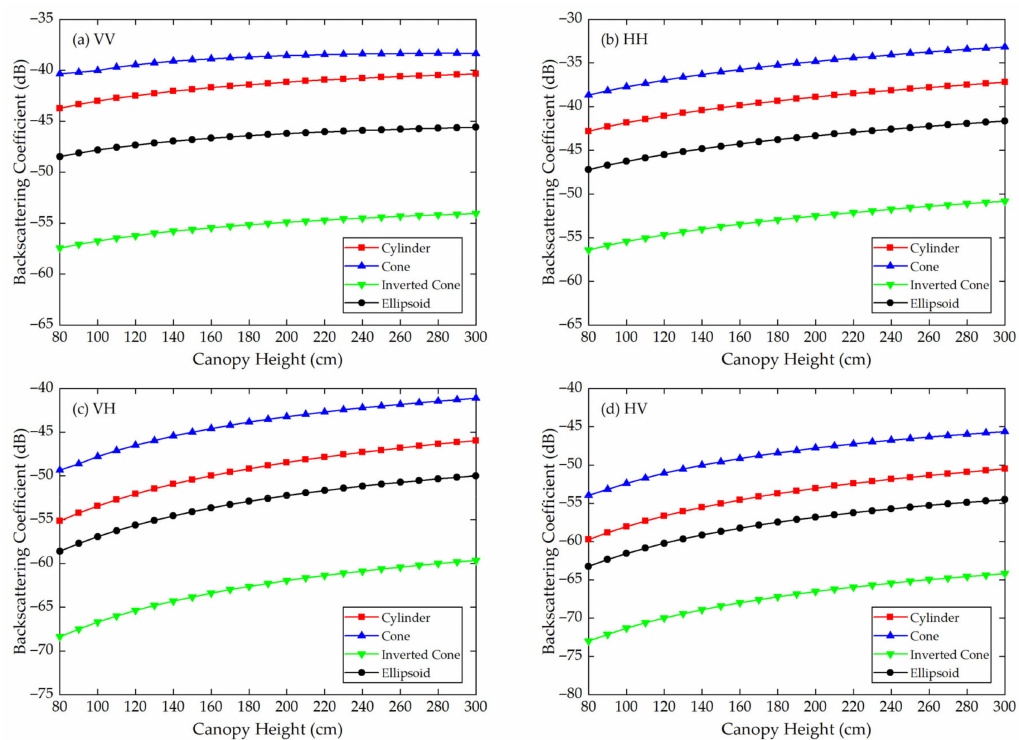
Figure 11. The MTVM simulation results of the backscattering coefficients for different crown shapes in C band (5.3 GHz) at